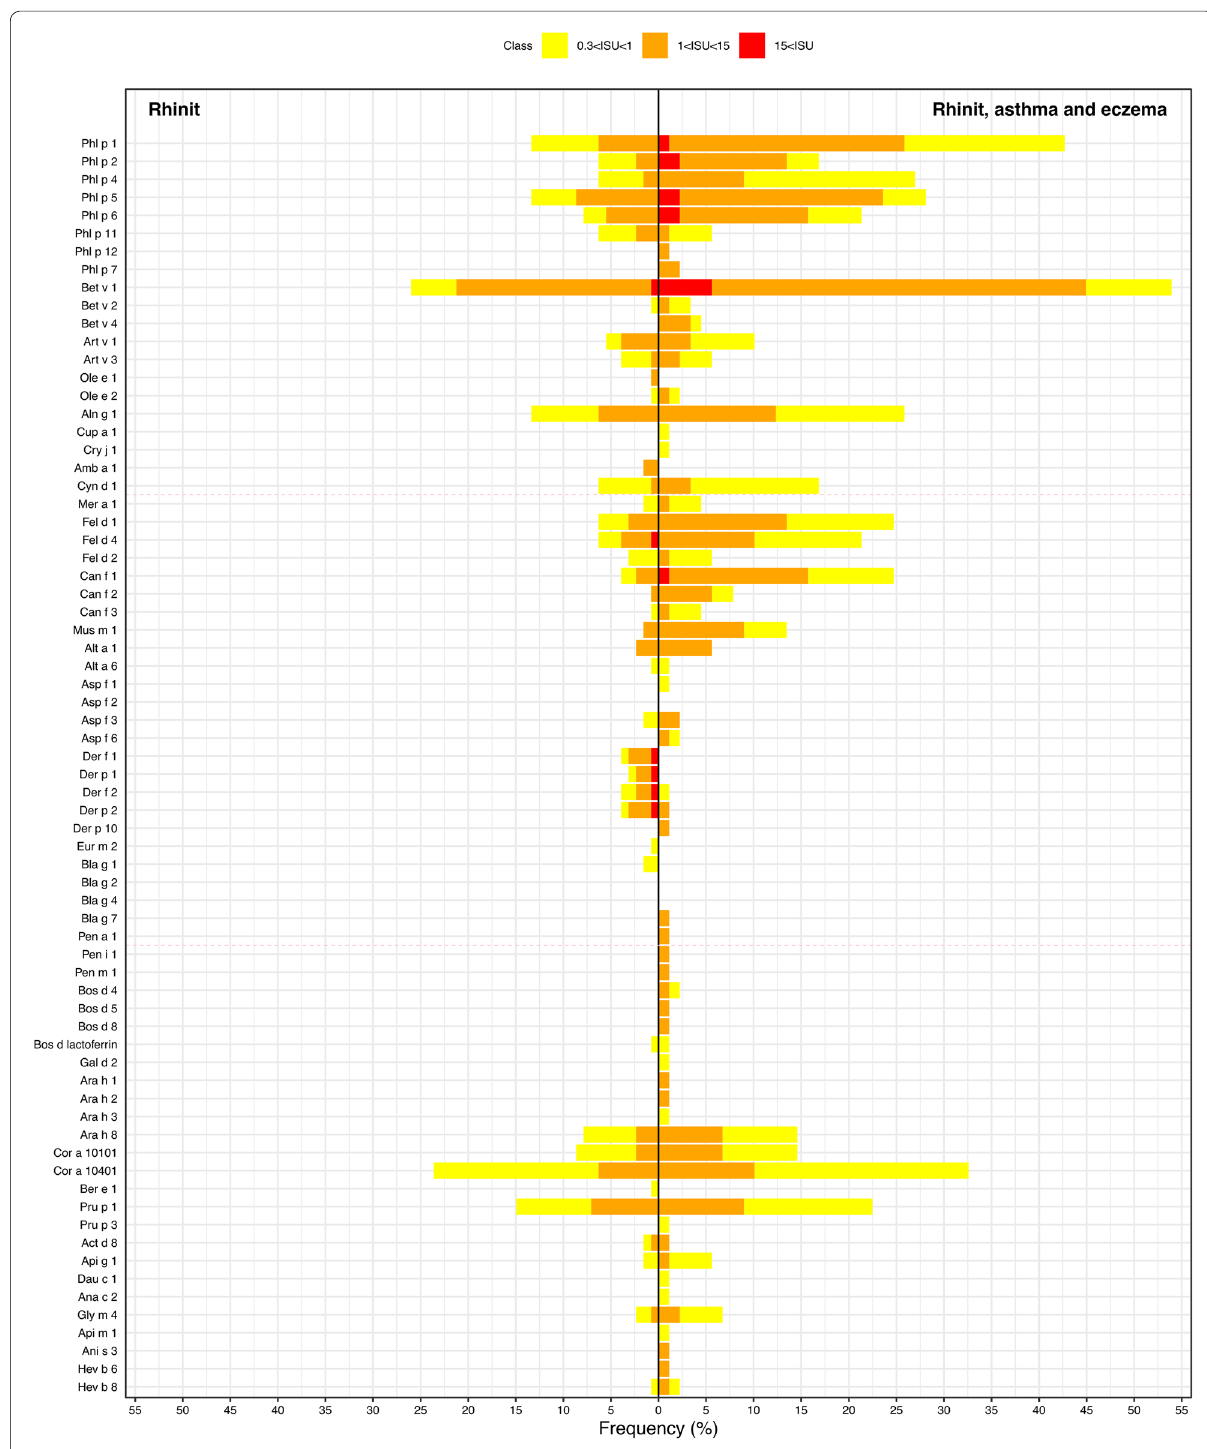
Fig. 3 Sensitisation to allergen components in the ISAC panel. *The column on the left represents subjects with only rhinitis and the column on the right subjects with rhinitis that also have eczema, asthma or both. The darker the colour (yellow, orange, red), the higher the test